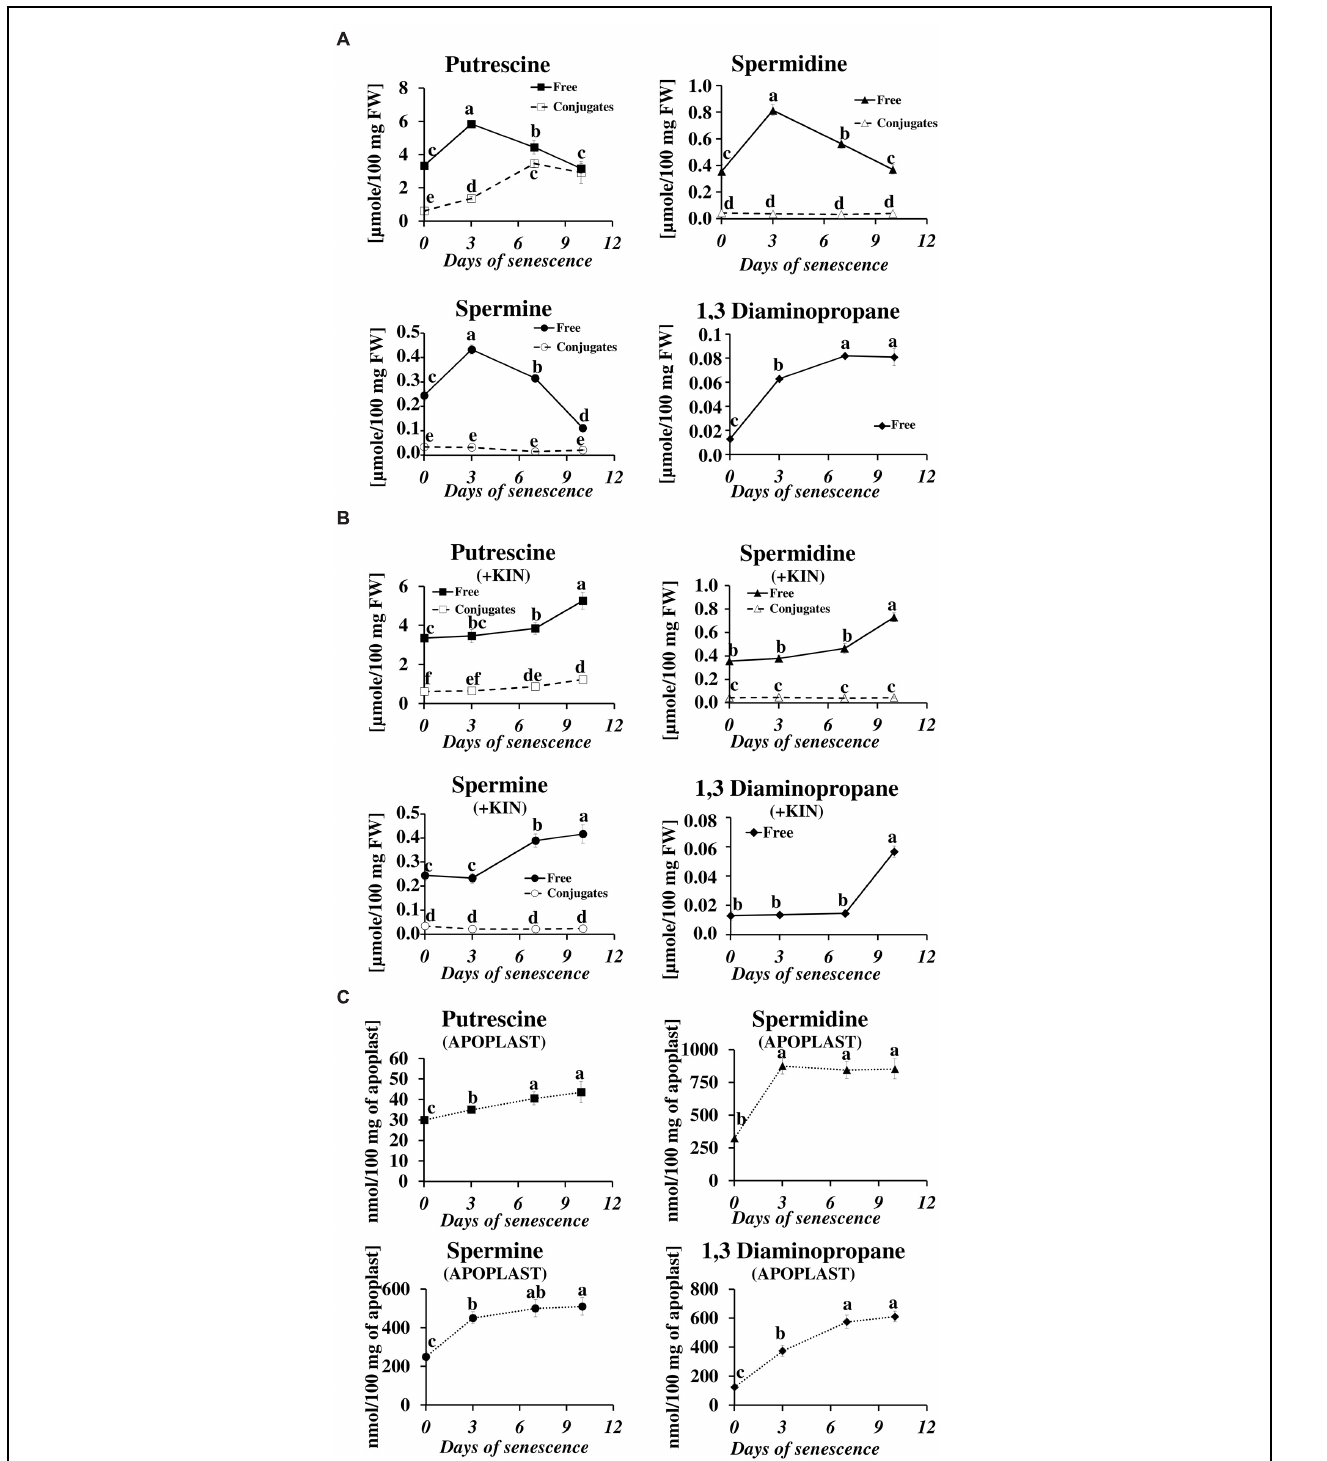
FIGURE 1 | Senescence-related changes in free, conjugated and apoplastic fluid polyamine levels in dark-incubated barley leaves. (A) Free (solid line) and conjugated (dashed line) polyamines. (B) Free (solid line) and conjugated (dashed line) polyamines in leaves additionally treated with exogenous 400 μ M kinetin (KIN). (C) Apoplastic fluid polyamines. Putrescine, spermidine, spermine, and diaminopropane concentrations were determined through senescence using HPLC after polyamine derivatization with dansyl chloride. The values are reported in micromoles relative to leaf fresh weight (FW). The differences in the measured parameters were analyzed for statistical significance using one-way analysis of variance (ANOVA) and the Tukey–Kramer Multiple Comparison Test ( n = 9, p < 0.01). The same letters on bars describe non-significant differences between means.